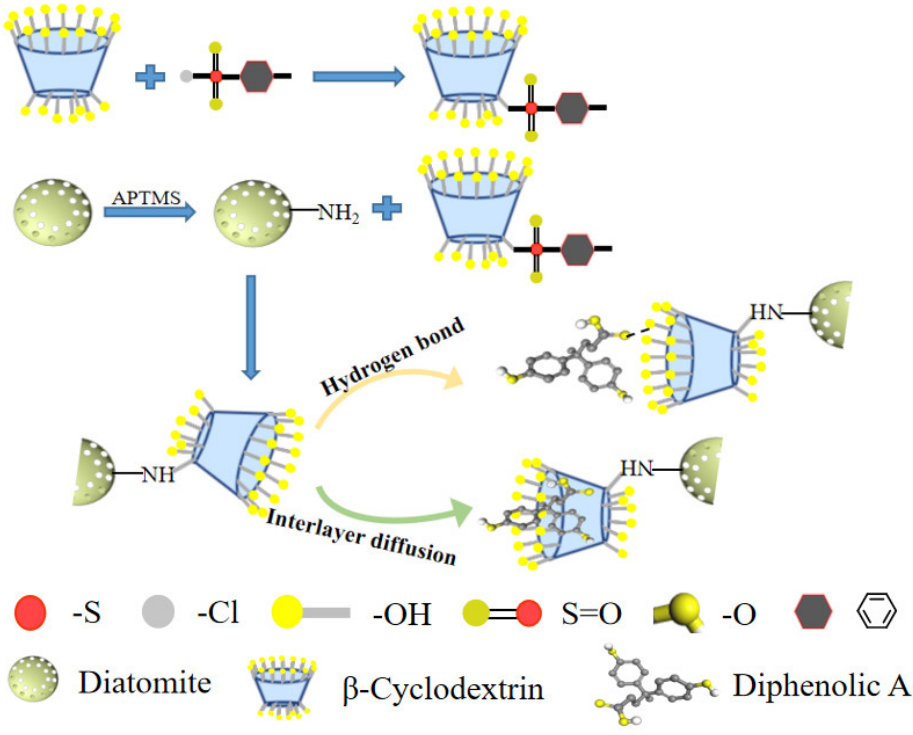
Scheme 1. Schematic diagram of the preparation of DA/ β -CD